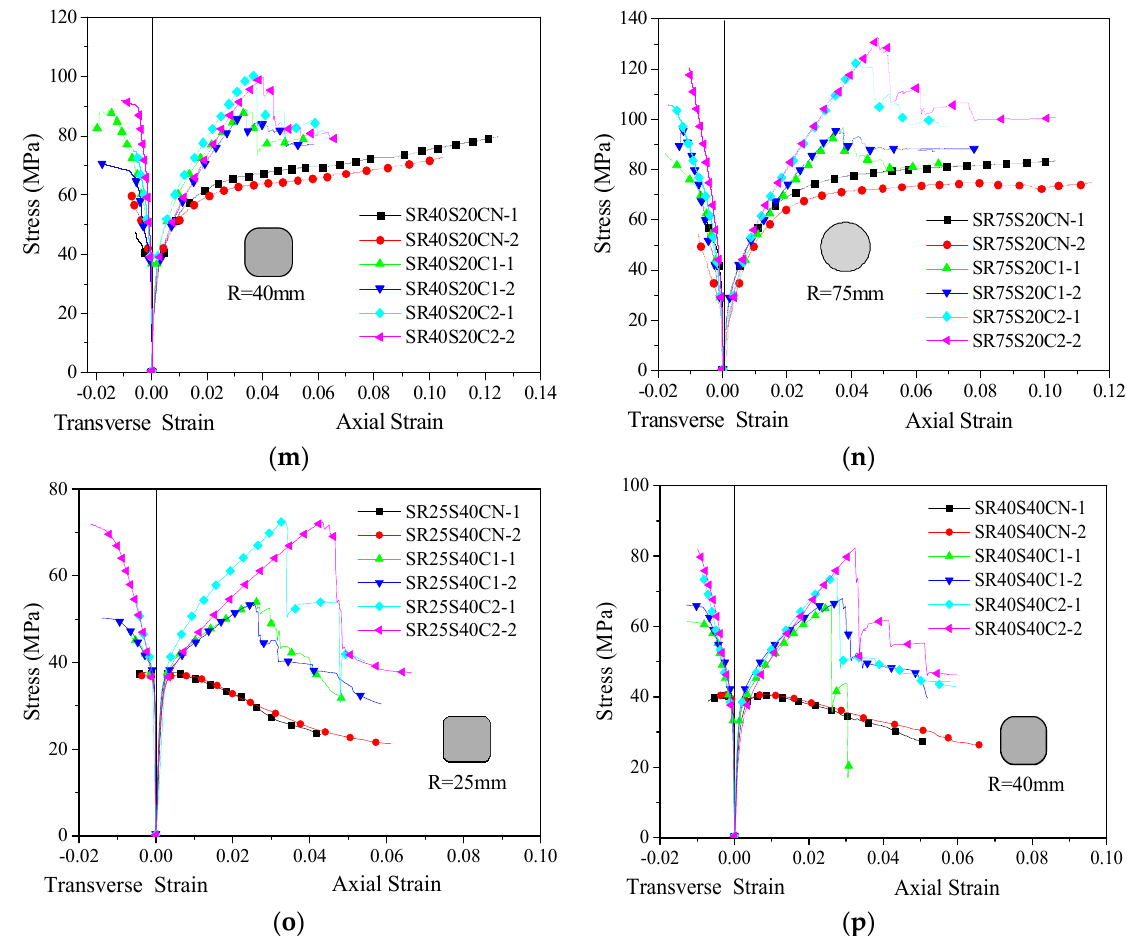
Figure 6. Stress-strain relationship curves of the specimens: ( a ) PC-BC; ( b ) PC-BS; ( c ) SR5S20B; ( d ) SR25S20B; ( e ) SR40S20B; ( f ) SR75S20B; ( g ) SR25S40B; ( h ) SR40S40B; ( i ) PC-CC; ( j ) PC-CS; ( k ) SR5S20C; ( l ) SR25S20C; ( m ) SR40S20C; ( n ) SR75S20C; ( o ) SR25S40C; ( p ) SR40S40C.